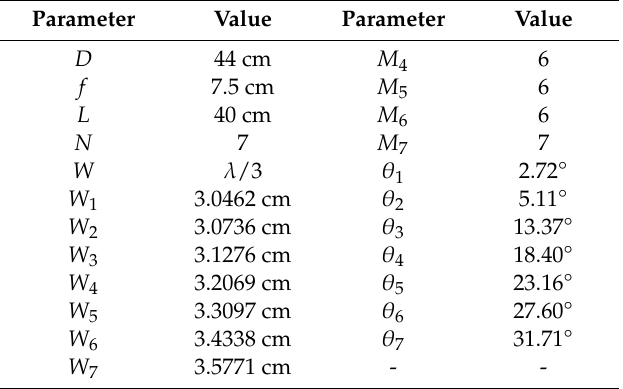
Table 1. Dimensions of the segmented reflector shown in Figure